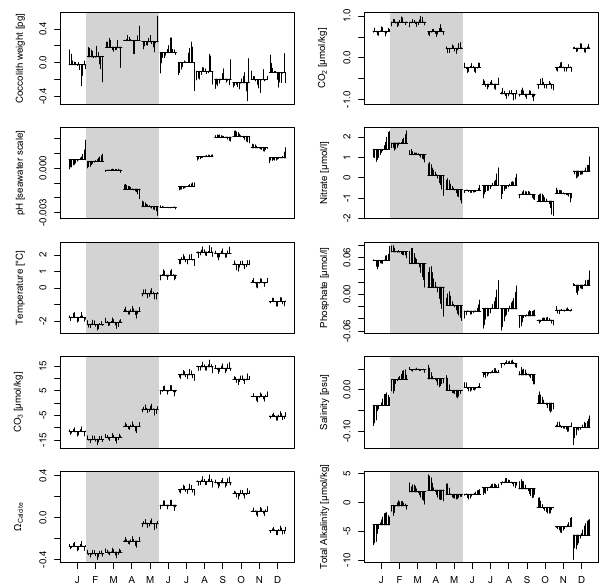
Figure 5. Seasonal signal extracted from the weight and environ- mental data in Fig. 4 by a single spectrum analysis (SSA). Monthly averages and the deviation from the average for every year (bars) are